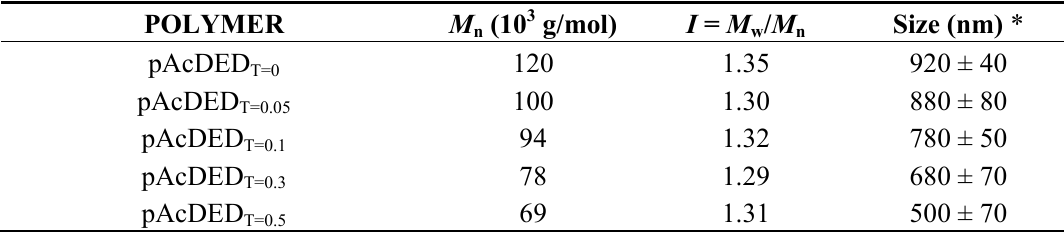
Table 1. Molecular weight, polydispersity index and dynamic light scattering (DLS) size of synthesized